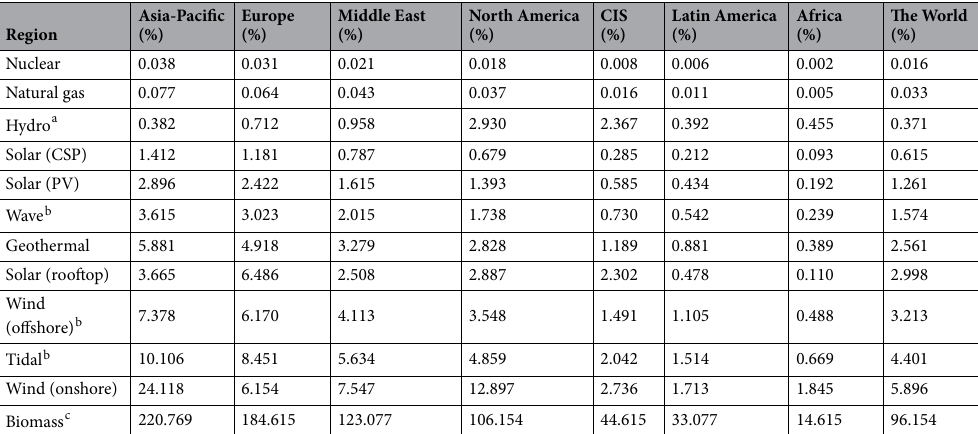
Table 18. Spatial requirements for the different power sources to meet 100% of the primary energy use, normalized by the world’s land area, based on Eq. (5), where A g / A tot ≈ p c / p g = ε c /ε g . The 2020 energy use (provided in Table 15) and the mean power density of the energy sources given by region or globally are listed in Tables 8, 11, and 16. It is assumed that all areas are amenable to each source and that they face no limitations in terms of scalability other than their mean annual energy densities. a The energy density of hydro power depends on the region and is constrained by natural resources, limiting the scalability. b The required sea area scenario uses the meta-analysis of van Zalk and Behrens 3